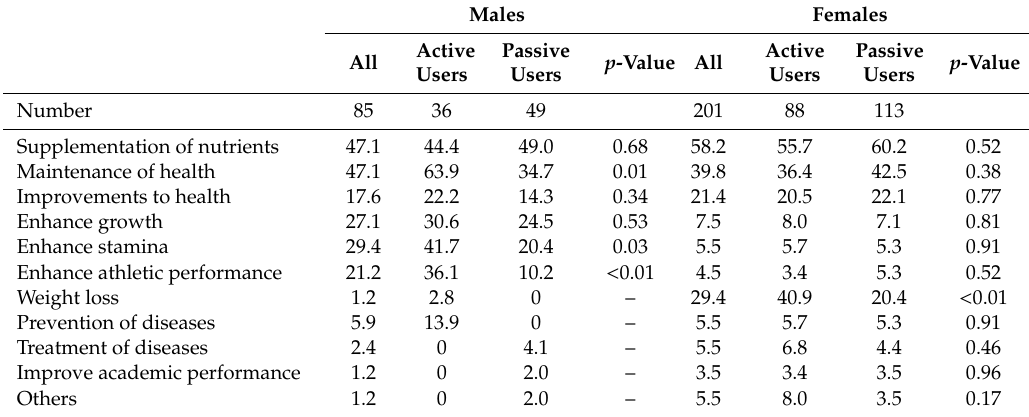
Table 4. A comparison of the purpose of the use of dietary supplements in active and passive users (% of respondents).